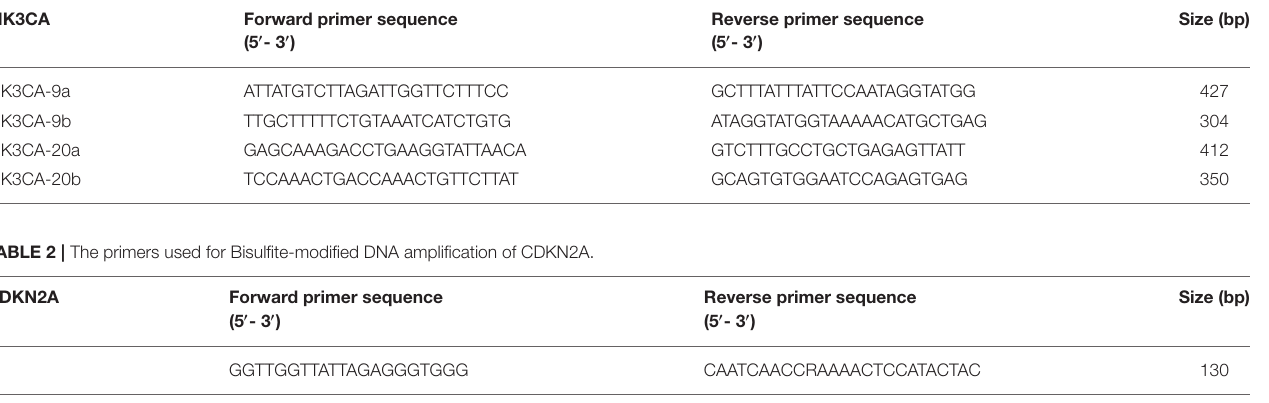
TABLE 1 | The primers used for nested PCR and sequencing of PIK3CA. PIK3CA Forward primer sequence (5 ′ - 3 ′ )